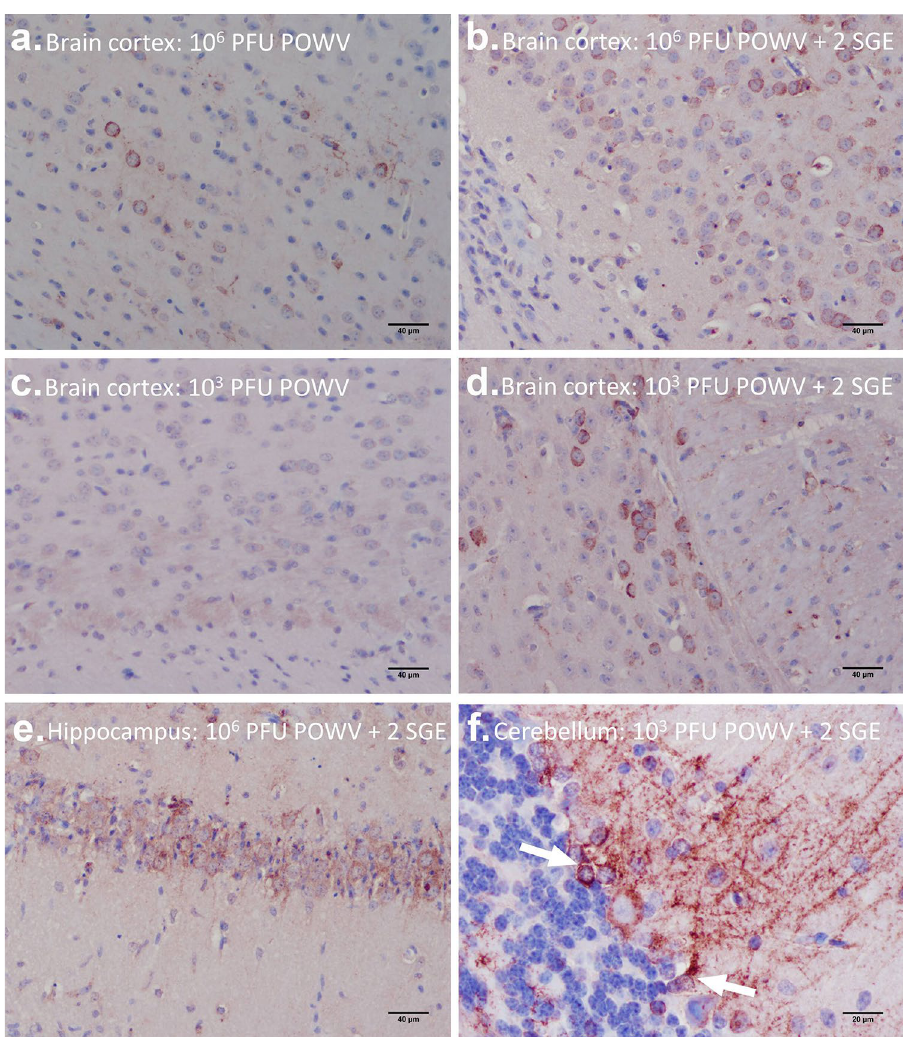
Figure 2. Immunohistochemistry for POWV detection in the brain. ( a ) 10 6 PFU POWV, brain cortex. ( b ) 10 6 PFU POWV + 2 SGE, brain cortex. ( c ) 10 3 PFU POWV, brain cortex. ( d ) 10 3 PFU POWV + 2 SGE, brain cortex. ( e ) 10 6 PFU POWV + 2 SGE, hippocampus. ( F ) 10 3 PFU POWV + 2 SGE, cerebellum. ( a – e ) Scale bars represent 40 µm. ( f ) Scale bars represent 20 µm. Arrows point to Purkinje